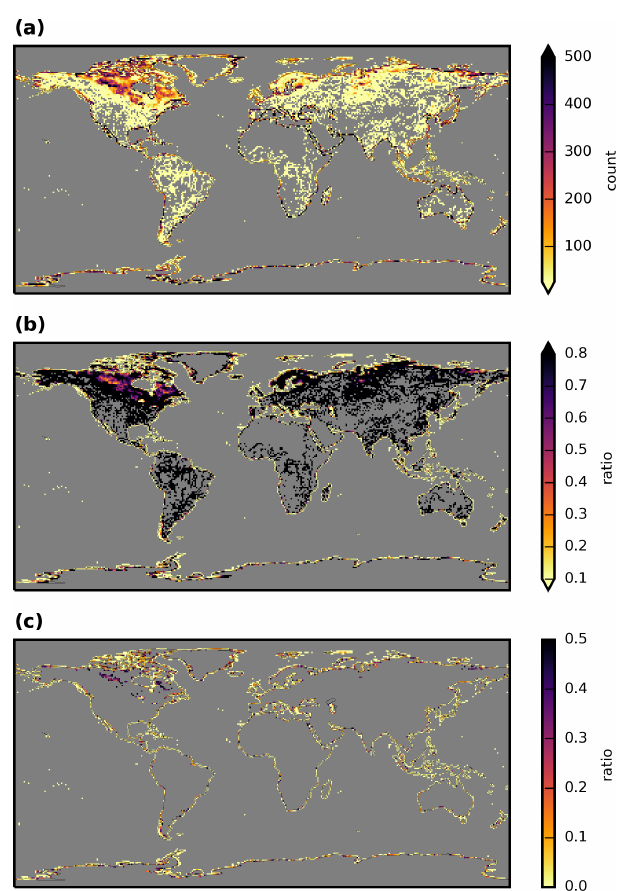
Figure 2. Maps showing the stages of derivation of the coastal L3 grid box mask applied in this paper to MOPITT data. (a) Frequency with which L3 grid boxes are given the surface index of mixed, cal- culated from daily data between 25 August 2001 and 28 February 2019. (b) Frequency with which L3 grid boxes that have a surface index of mixed at least once in panel (a) have the surface index of land, compared to the total number of days with which L3 data are available for that grid box (expressed as n _days(L3O L / L3O)). (c) As (b) but with a threshold of n _days(L3O L / L3O) < 0.5 ap- plied. This is the coastal L3 grid box mask used in this paper.